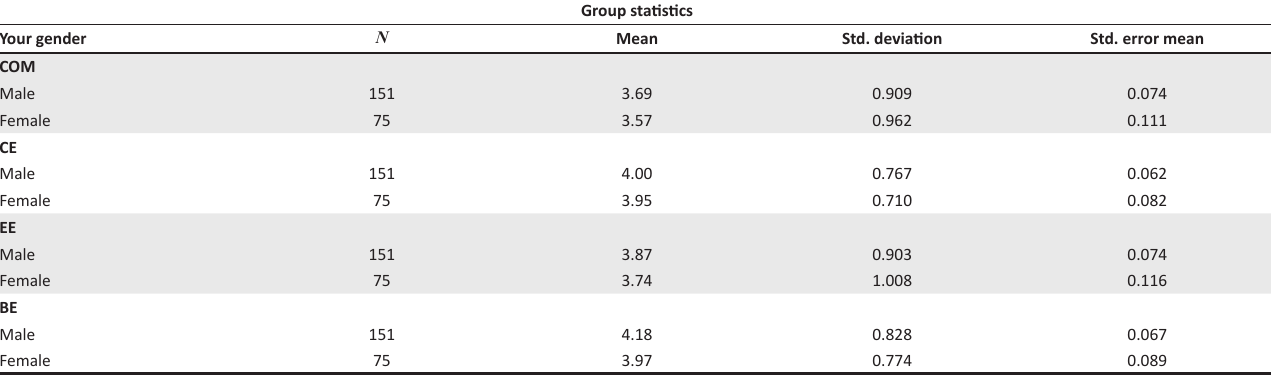
TABLE 4a: Independent t -test